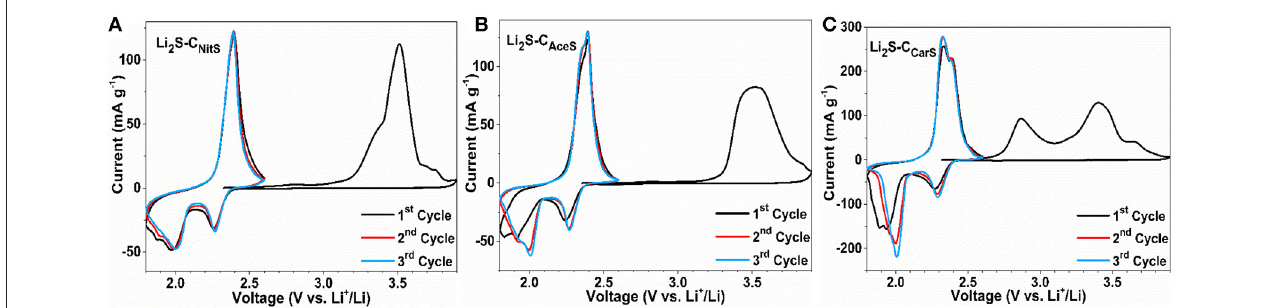
Frontiers in Chemistry |